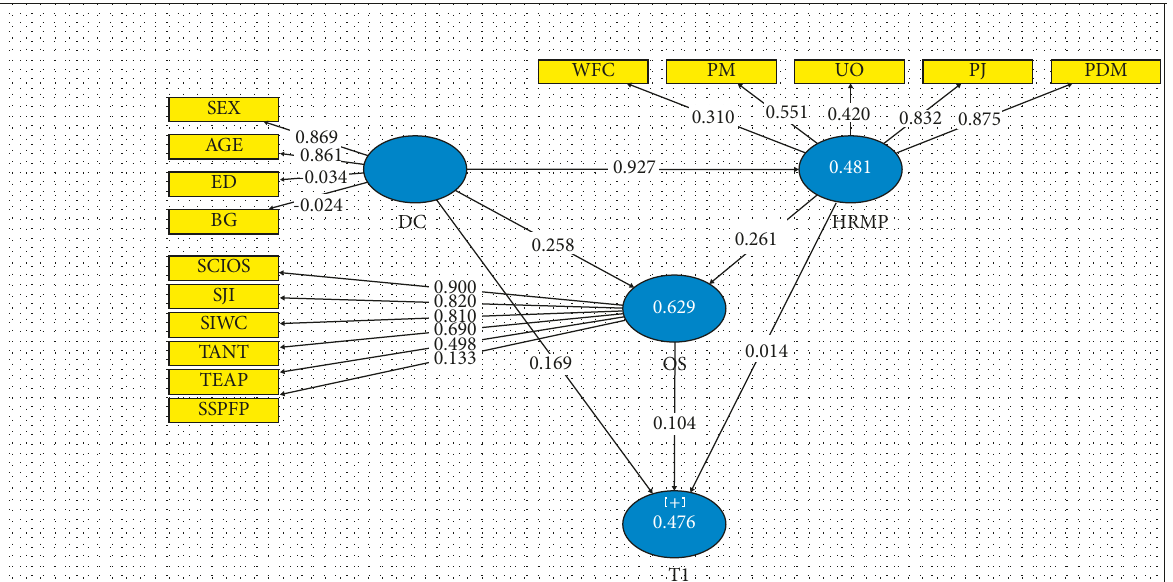
Figure 2: Model path coefficients.